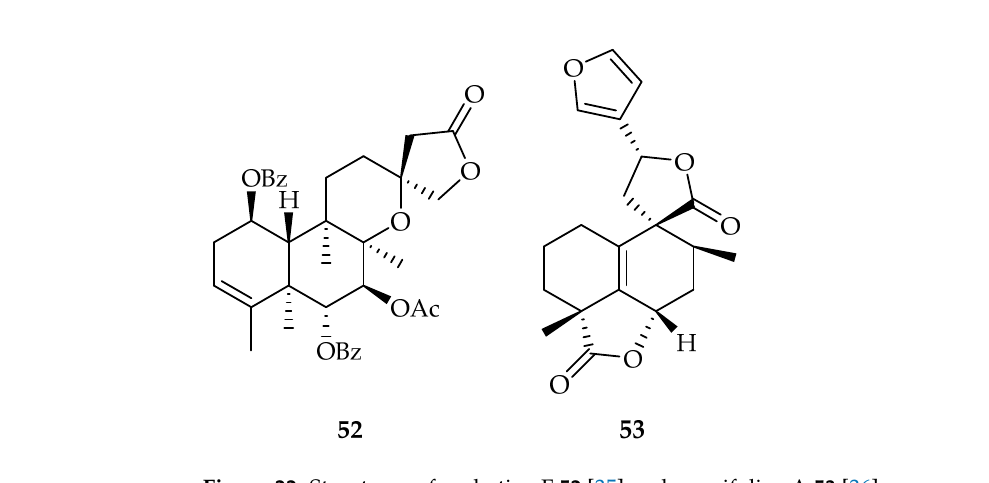
Figure 22. Structures of scubatine F 52 [35] and crassifolius A 53 [36].